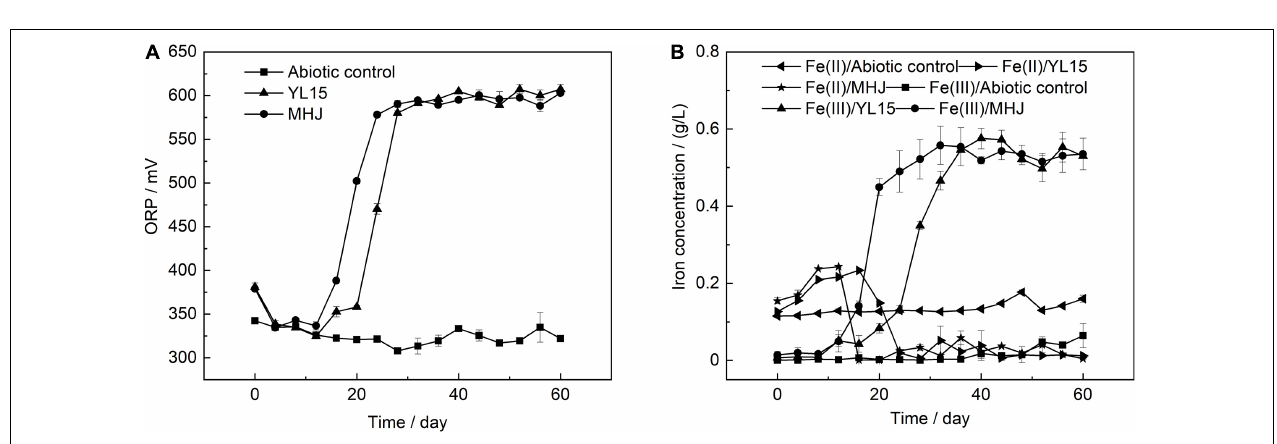
FIGURE 2 | Variations of (A) ORP and (B) ferric and ferrous iron concentrations during chalcopyrite